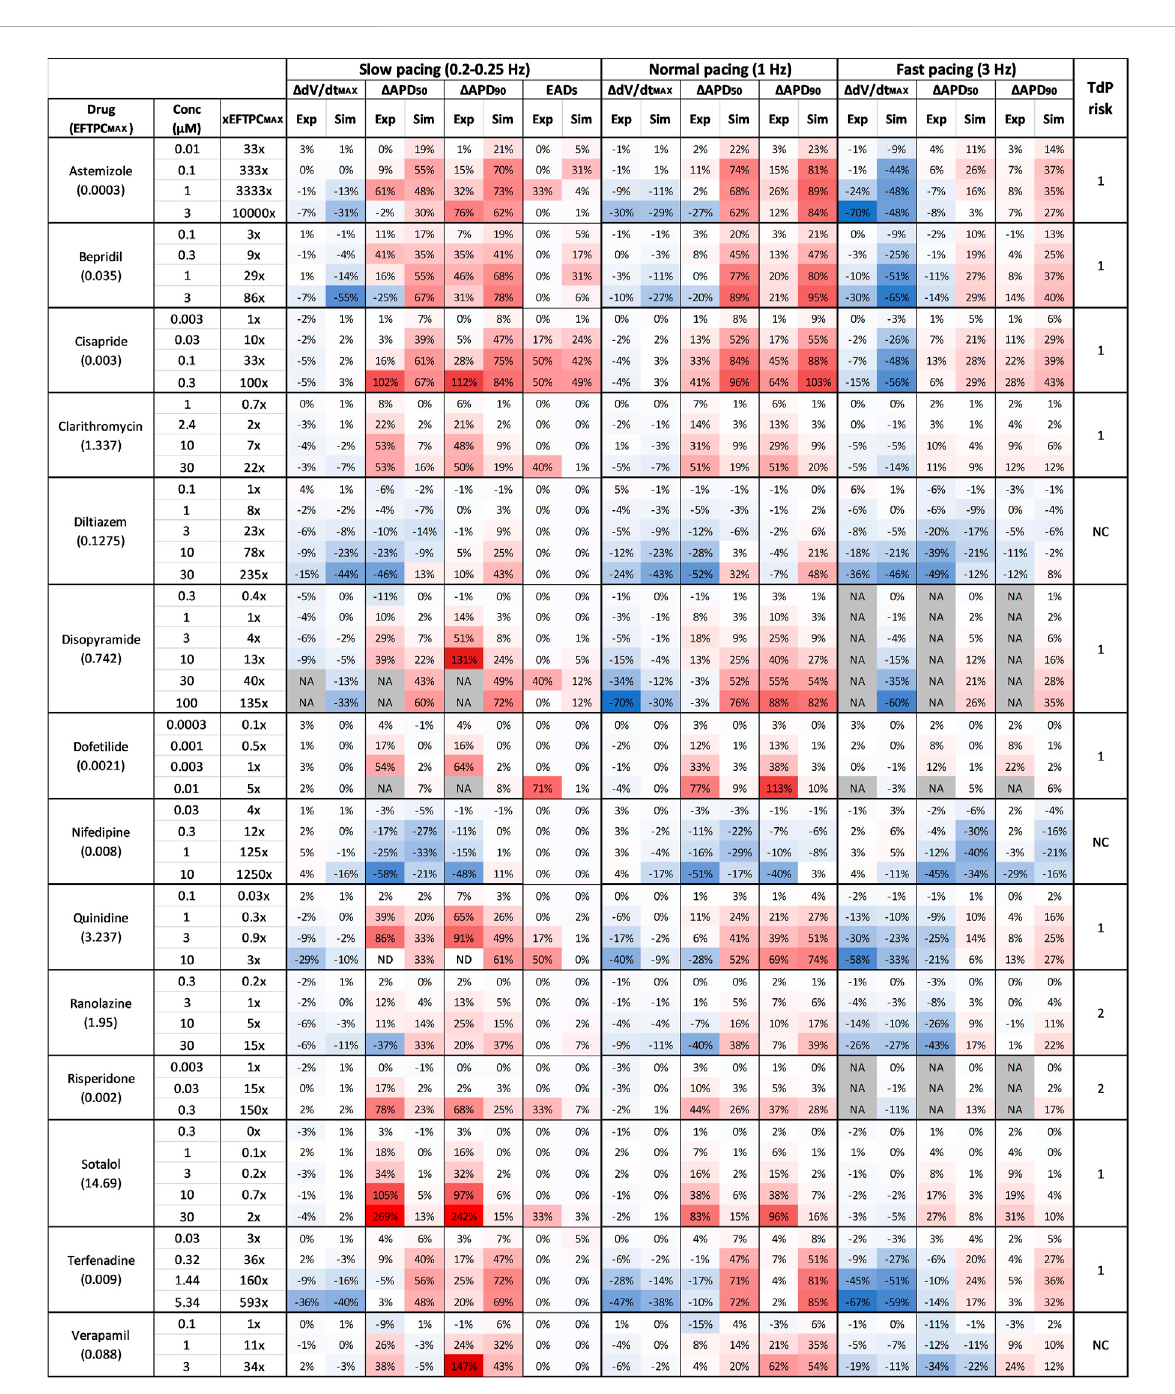
FIGURE 3 Comparison between clinical TdP risk and percent drug-induced AP changes in human simulations and rabbit experiments for each drug, at different concentrations and pacing frequencies. Columns description from left to right: fi rst: drug name and maximum effective free plasma concentrations (EFTPC MAX , in µM); second: tested drug concentrations; third: ratio between tested concentrations and EFTPC MAX ; from fourth to ninth: experimental and simulated AP biomarkers changes at slow pacing; 10th to 11th: percentage of EADs occurrences in simulations and experiments at slow pacing; from 12th to 23rd: experimental and simulated AP biomarkers changes at normal and fast pacing; 24th: drug risk categorybasedonCredibleMeds ® (WoosleyandRomer,1999):highrisk(1),conditionalrisk(2),NC(non-classi fi edinanyriskcategory).NA:data not available. Changes are shown as percentage with respect to control conditions. Colors indicates biomarker increase (red) or decrease (blue) and are scaled from the minimum to the maximum percent variations for each biomarker at each pacing